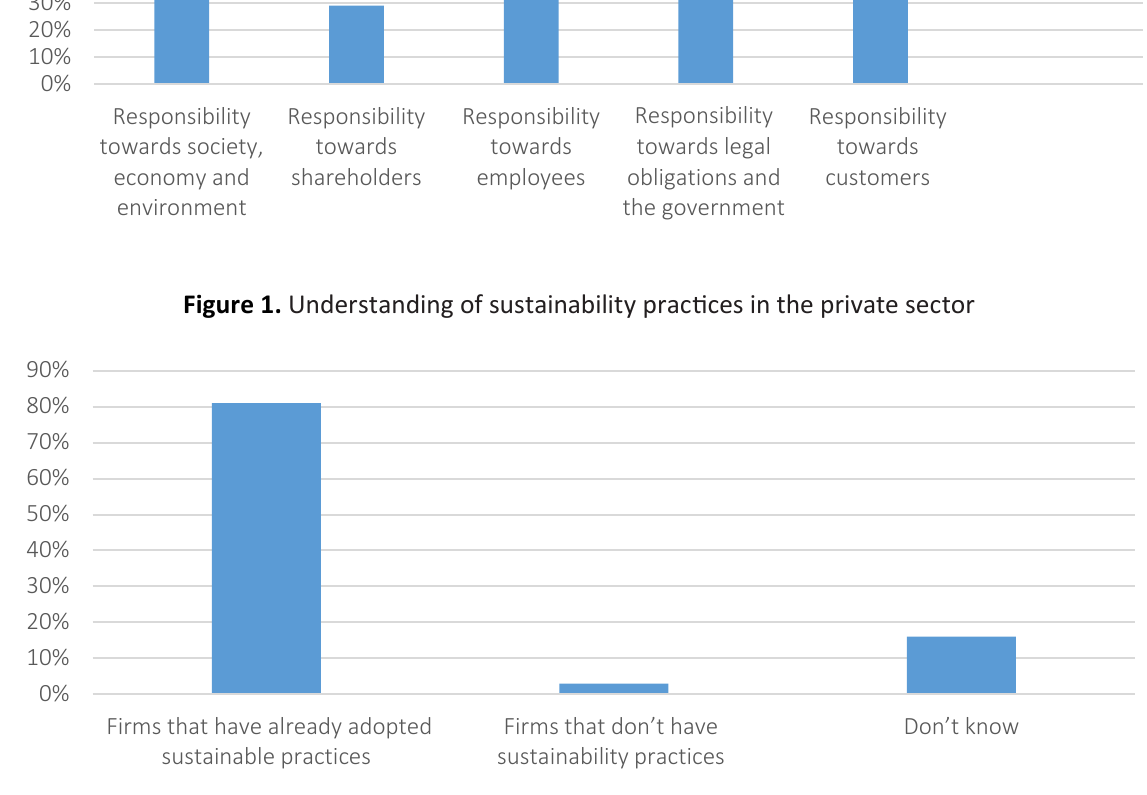
Figure 2. Firms eligible for full support during